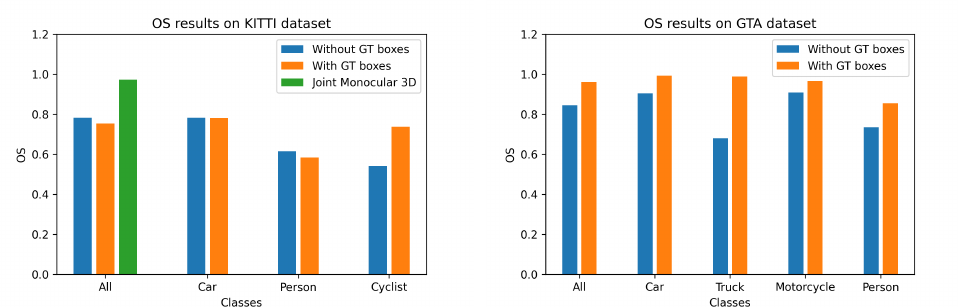
Figure 3. In these graphs, we compare the orientation score obtained by our method (with or without ground truth box) on the different dataset classes; we also include the results of the “3D joint monocular” method (which also uses ground truth boxes). We can see that our method has a lower orientation score when we do not use Ground truth (GT) bounding boxes. This can be explained by the fact that the boxes used for feature alignment during inference are the same as those used during